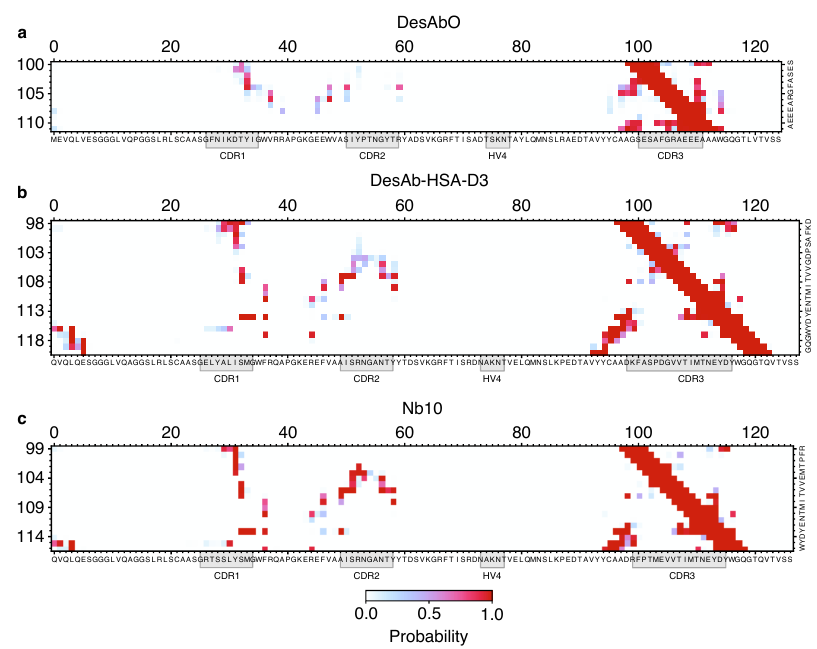
Figure 2. Comparison of the free energy landscapes of the 3 sdAbs studied in this work. The x and y axes represent the relative proportion of intra-CDR3 (CDR–CDR) and CDR3–scaffold (CDR–NB) contacts, respectively. Twenty randomly sampled structures are shown from each ensemble, with the CDR3 loop colored.